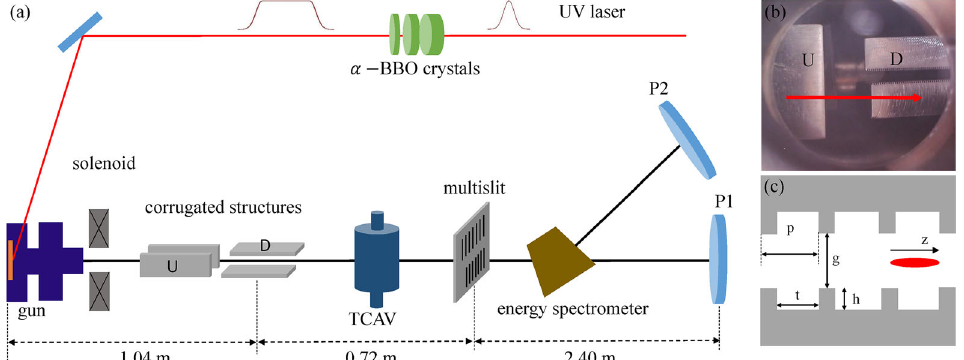
FIG. 1. (a) Schematic layout of the time-resolved measurement of quadrupole wakefields experiment (distances not shown in scale); (b) side view of the CS: upstream CS has a horizontal gap and downstream CS has a vertical gap (the red arrow indicates the beam direction); (c) geometry of the planar CS parameters (the red ellipse represents a beam propagating along the z axis).